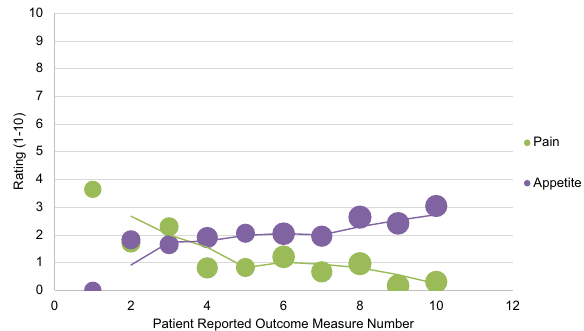
Fig. 7 Responses to post-procedure recovery patient-reported outcome measure questionnaires about pain and appetite among postoperative bariatric surgery patients. Post-procedure patient- reported outcome measure questionnaires were sent twice